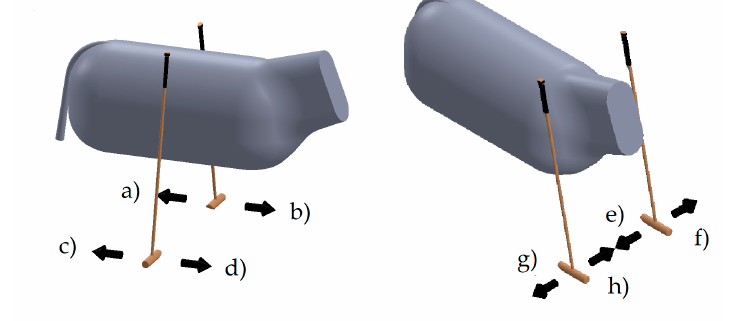
Figure 2. CAD models indicating the direction of swing of the polo mallet in relation to the pony. Standard shots, ( a ) back nearside, ( b ) front nearside, c) back offside, ( d ) front offside. Neck shots, ( e ) backhand nearside, ( f ) forehand nearside, ( g ) backhand offside, ( h ) forehand offside.